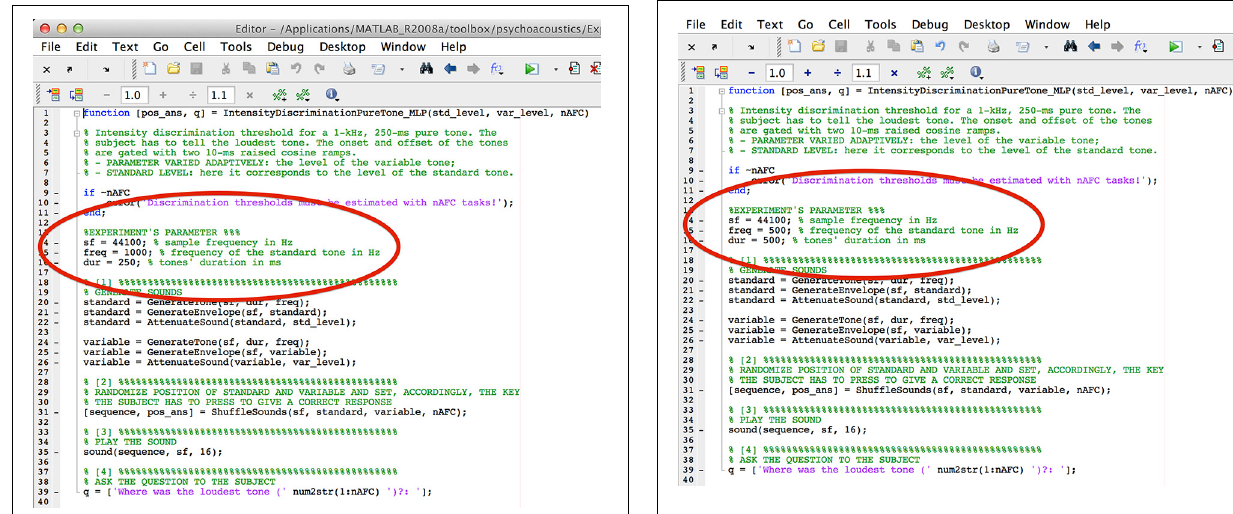
FIGURE 7 | Screenshot of the file IntensityDiscriminatioPureTone.m after the frequency and the tone duration have been changed.